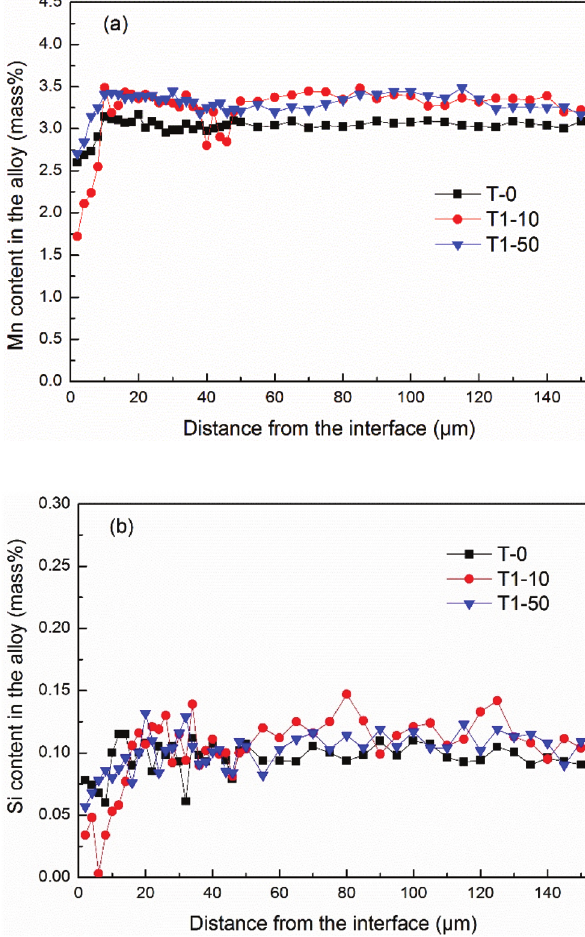
Figure 6: Variation of Mn and Si contents in the alloy away from the interface after heat treatment at